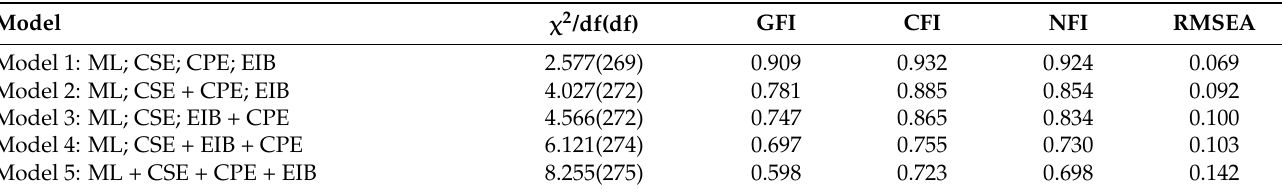
Table 1. Confirmatory Factor Analysis.